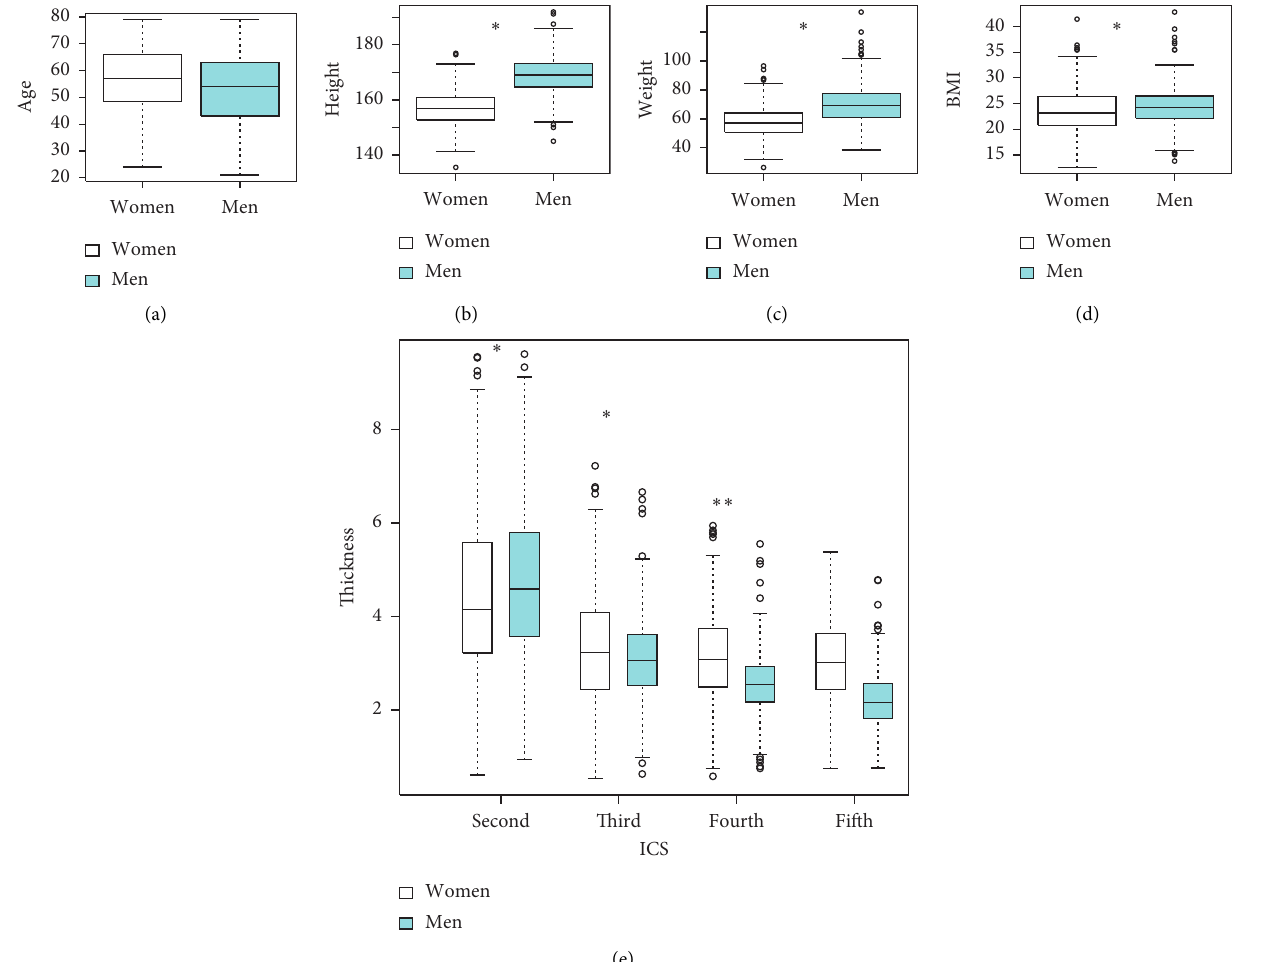
Figure 1: Participant characteristics (women ( N � 268); men ( N � 382)); ∗ significant difference between women and men. (a) Age. (b) Height. (c) Weight. (d) BMI. (e) CWT.